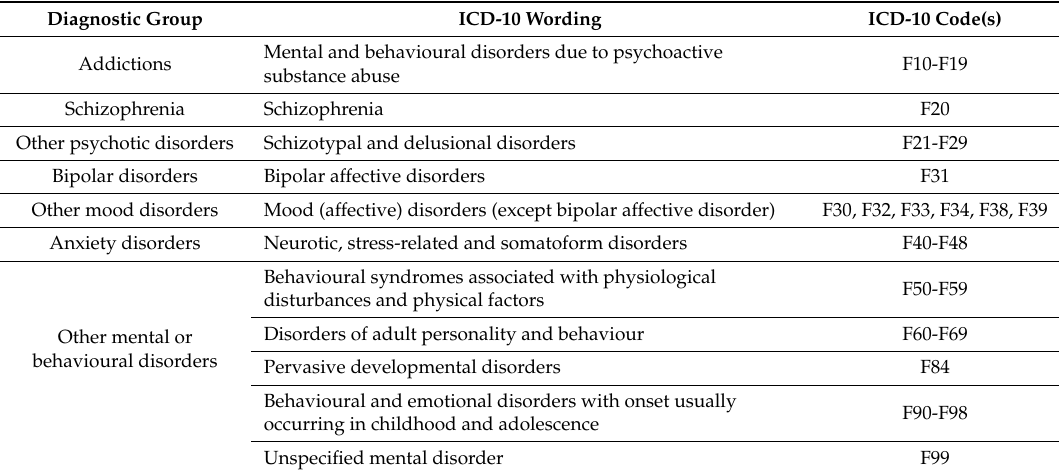
Table 1. Diagnostic groups included in the